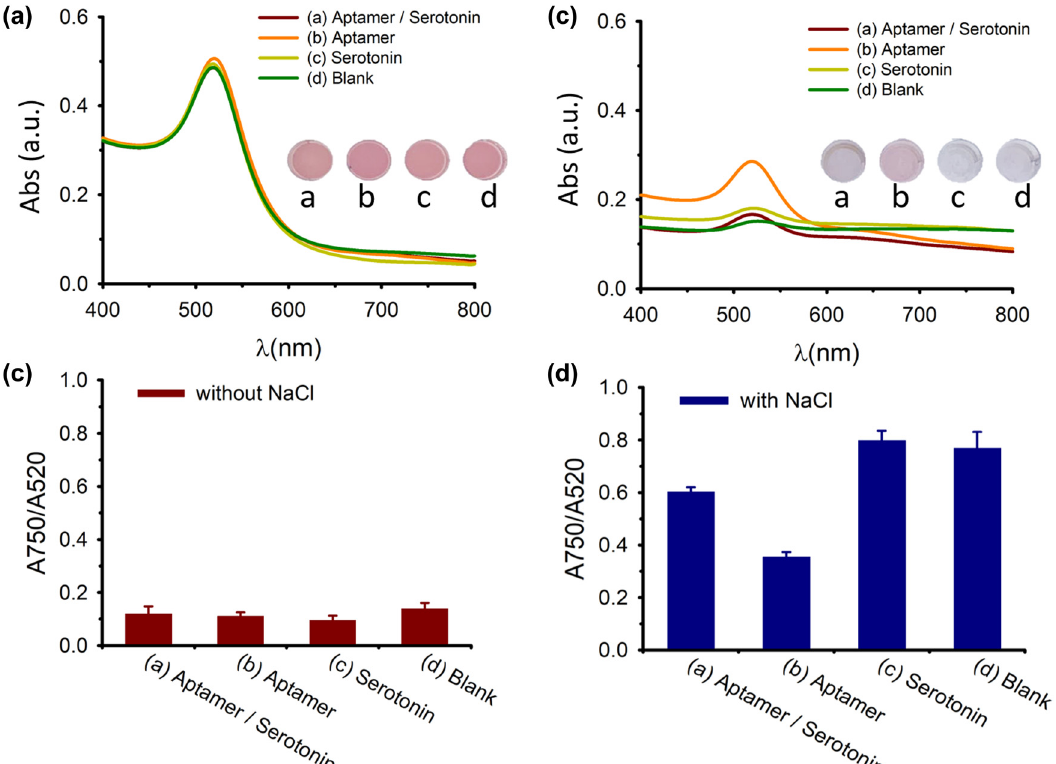
Figure 1: UV - Vis absorption spectra of the colorimetric assay in the di ff erent conditions ( a ) with and ( b ) without adding NaCl. Inset shows the images of the color change of the AuNP solution. The ratio of the absorbance at 750 and 520 nm of the AuNP solution ( c ) with and ( d ) without adding NaCl in the presence of ( a ) aptamer and serotonin, ( b ) aptamer, ( c ) serotonin, and ( d ) blank. The fi nal concentrations of aptamer, serotonin, and NaCl were 20 nM, 10 ng/mL, and 32 mM, respectively, and their pH was 4. The error bars represent the standard deviation of the mean of three measurements ( for the representation of the curves in this fi gure in color, the reader is referred to view the web version of this article )